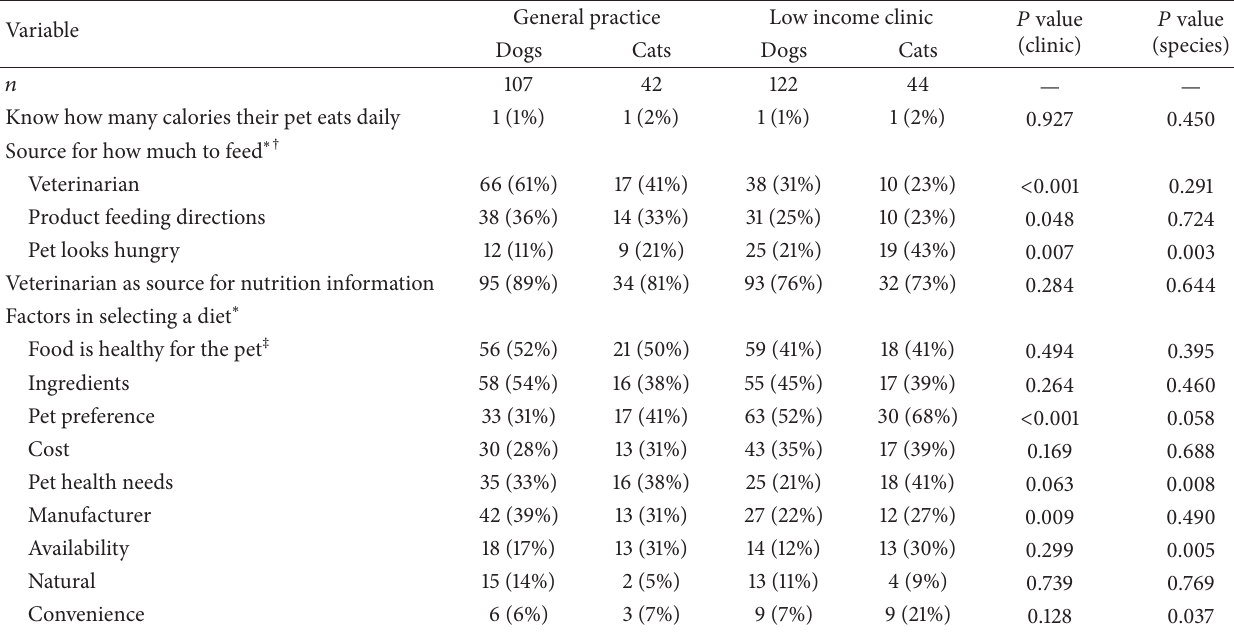
Table 5: Summary of responses from 229 dog and 86 cat owners from two veterinary clinics (general practice, 𝑛 = 149 ; low cost clinic, 𝑛 = 166 ). Number of owners providing each response, with percentage in parentheses.